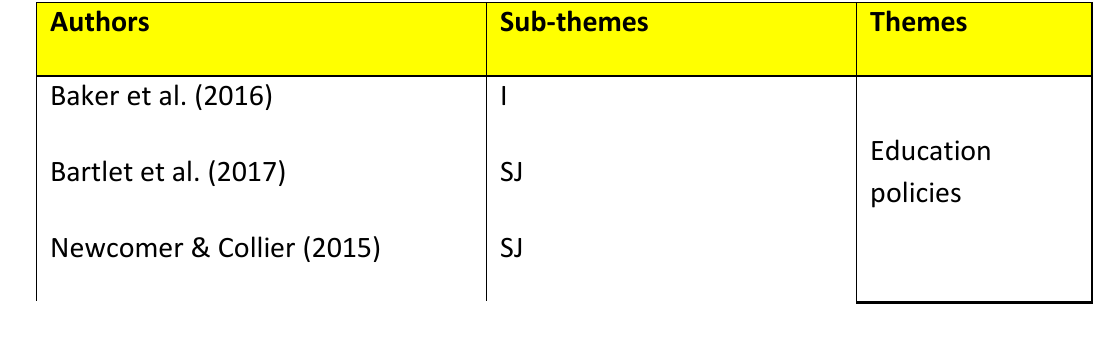
Table 3. Themes and sub-themes per